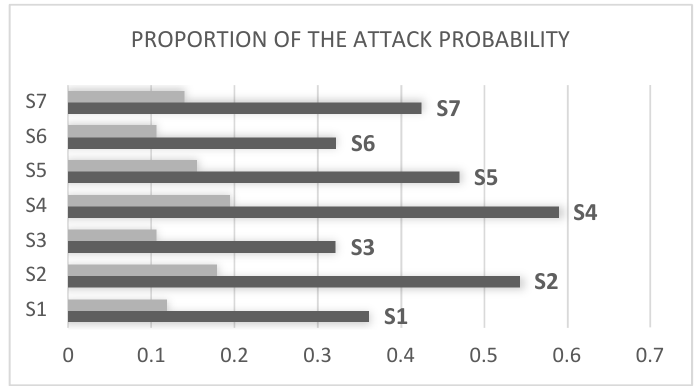
Figure 8. Proportions of the attack path probability for the DAS cases.